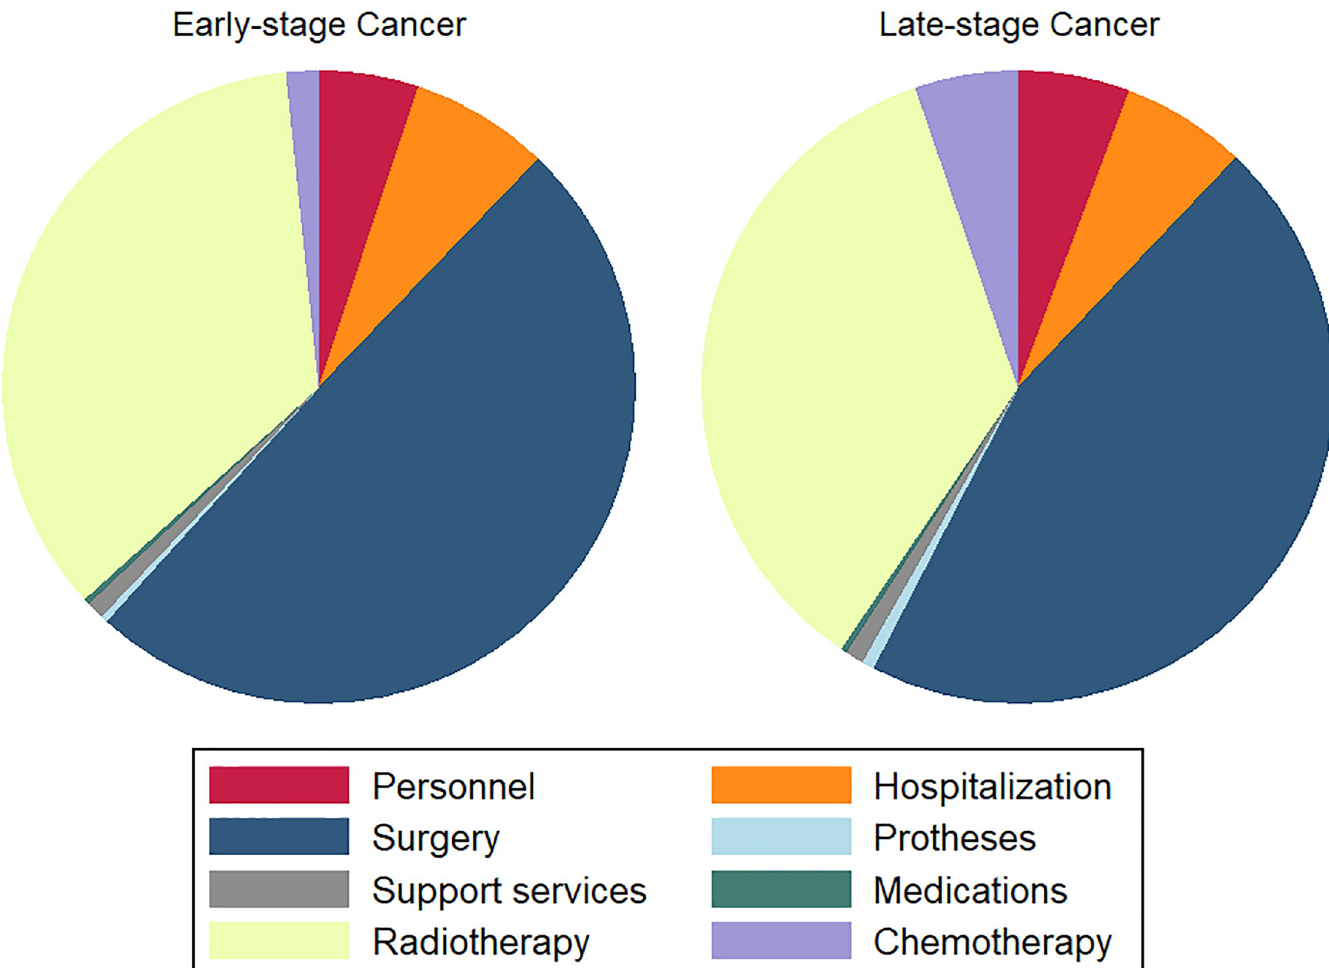
Fig 3. Chart of inpatient cost breakdown for early- and late-stage cancer.